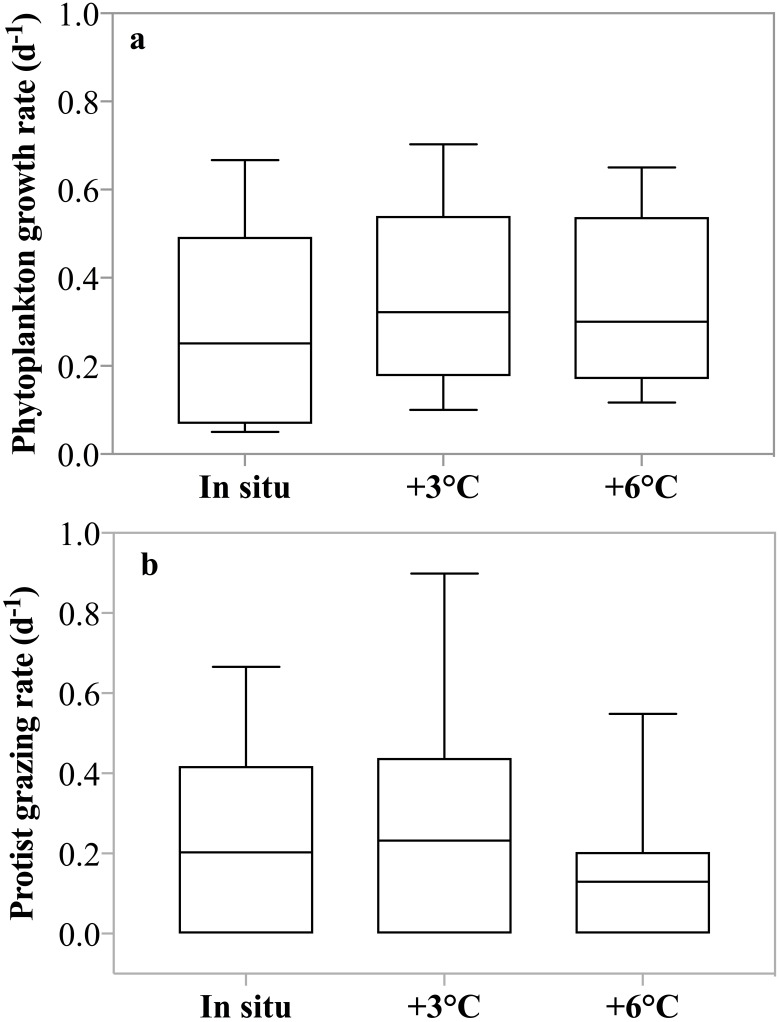
Temperature dependence of phytoplankton growth and herbivorous grazing rates.(A) Phytoplankton growth rates (d−1) in the 3 temperature treatments: in situ, +3 °C and +6 °C. Data shown are all replicates from all experiments with positive growth rates, after May 1st. (B) Protist grazing rates (d−1) for all incubations at in situ, +3 °C and +6 °C. Boxes indicate the mean and upper and lower 25th and 75th percentiles and the whiskers contain 95% of the data range.